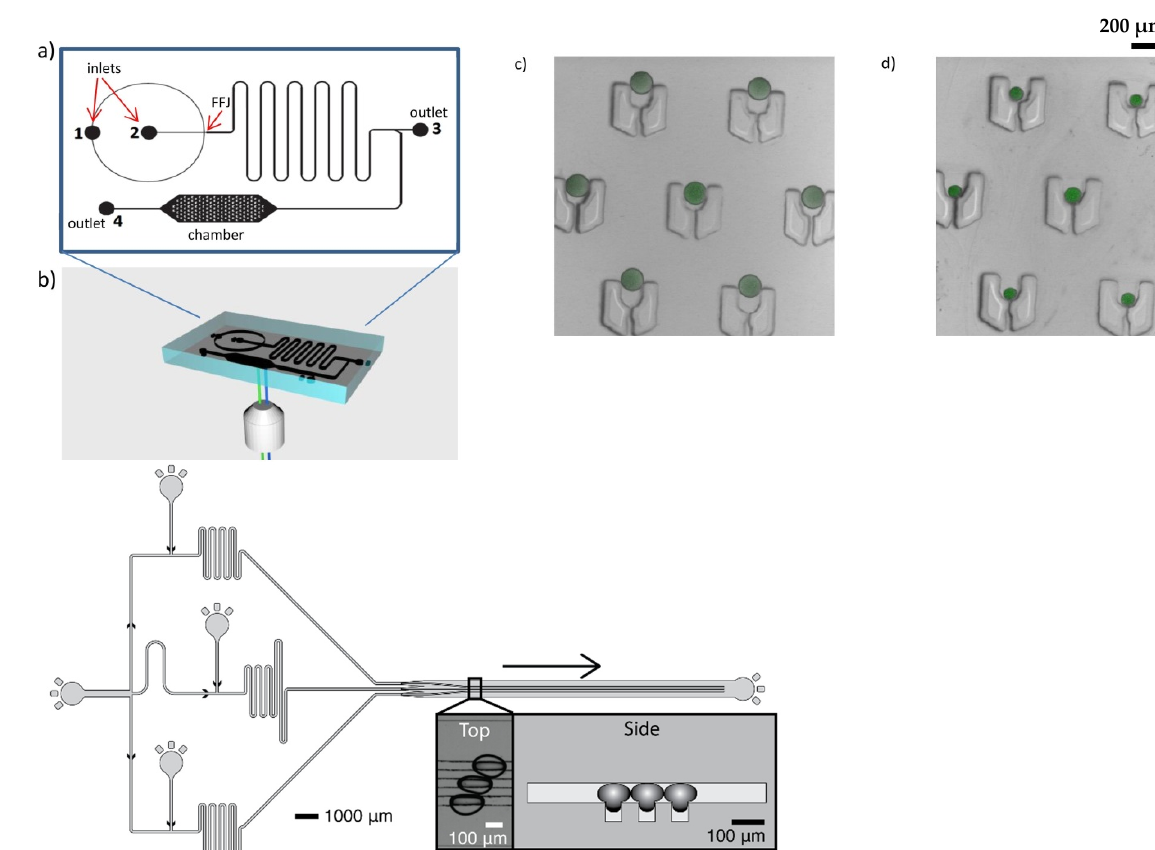
Figure 12. Top: Microfluidic device ( a ) and setup ( b ) for the analysis of triglyceride digestion and lipophilic micronutrient release from trapped droplets. Confocal fluorescence images of trapped tricaprylin droplets containing beta-carotene before ( c ) and after 24 min intestinal digestion ( d ). Reprinted from [134] with permission from Elsevier. Bottom: Microfluidic device for the analysis of bioactive compound transport kinetics between aqueous droplets, as designed in [137]. Image courtesy of Katherine Elvira, University of Victoria,